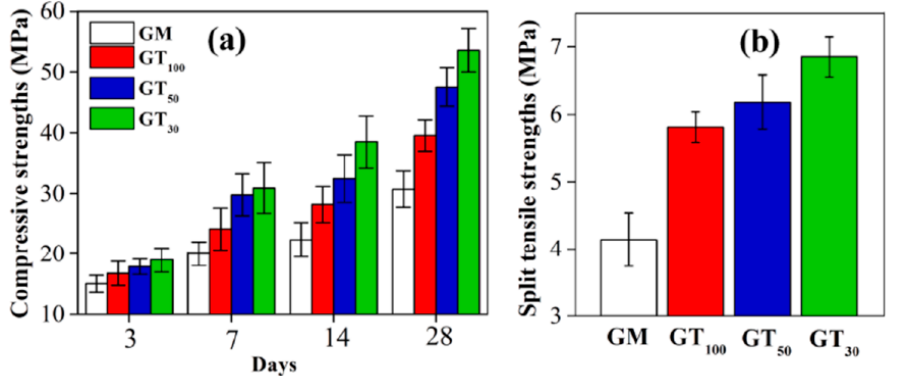
Figure 11. ( a ) CS and ( b ) STS development of alkali-activated specimens made with various nano- titanium contents [179].